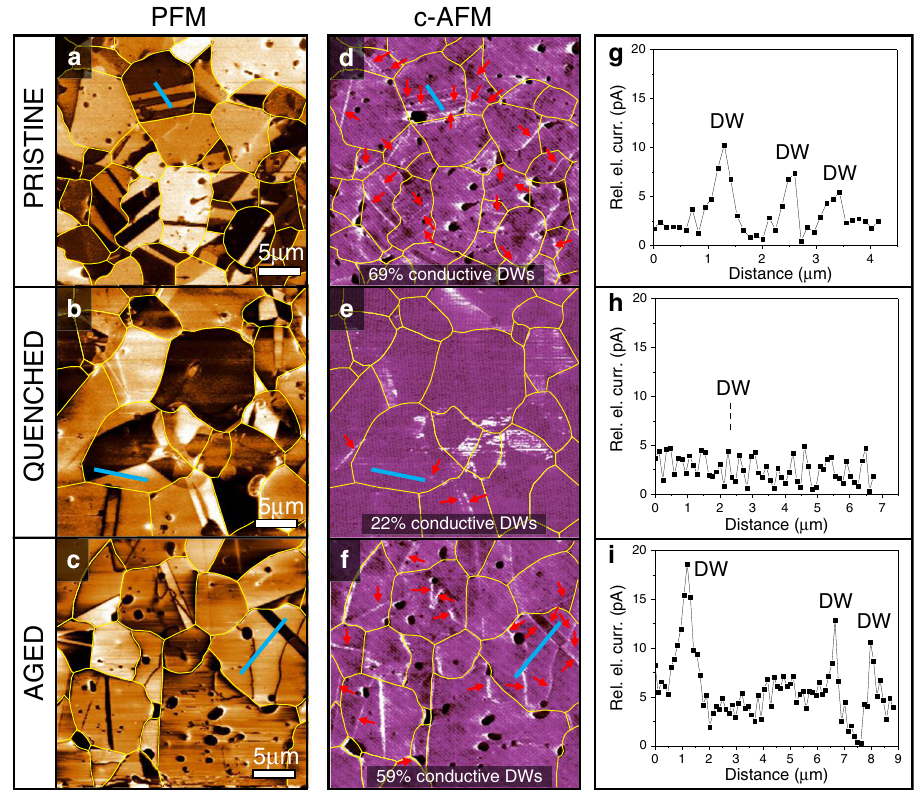
Fig. 3 Electrical-current signals at DWs in pristine, quenched and aged BiFeO 3 . a – c PFM out-of-plane amplitude images, d – f c-AFM maps and g – i electric-current pro fi les corresponding to a , d , g pristine, b , e , h quenched and c , f , i aged sample. The red arrows in the c-AFM images indicate the DWs with enhanced electric-current signal. The fraction of conductive DWs in the three samples is indicated on the respective c-AFM maps (this fraction was determined statistically on several sample regions by probing up to ~200 DWs per sample). The blue lines in the PFM and c-AFM images correspond to the distance along which the electric-current pro fi les, shown in panels g – i , were extracted. The DW positions along this distance are indicated on the pro fi les (DW — domain wall). The data are shown in units of relative electrical current, normalized to the lowest background signal arising from the domains. The grains in the PFM and c-AFM images were outlined to make the domains and DWs easier to